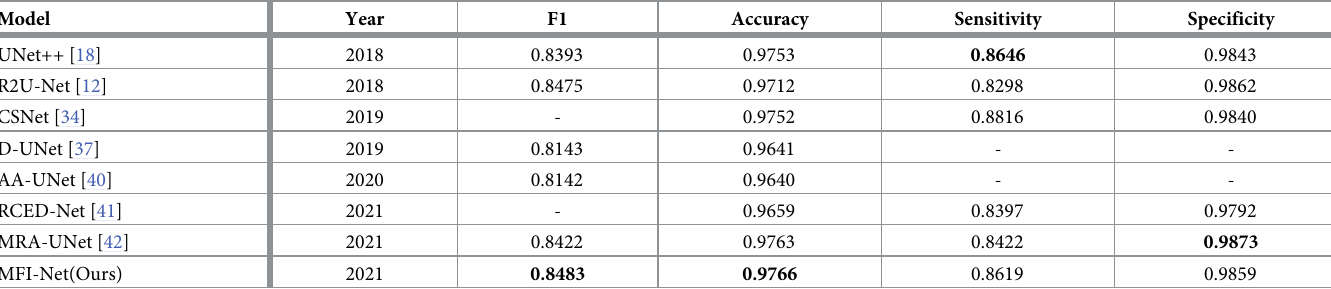
Table 5. Segmentation results of different models on the STARE dataset.